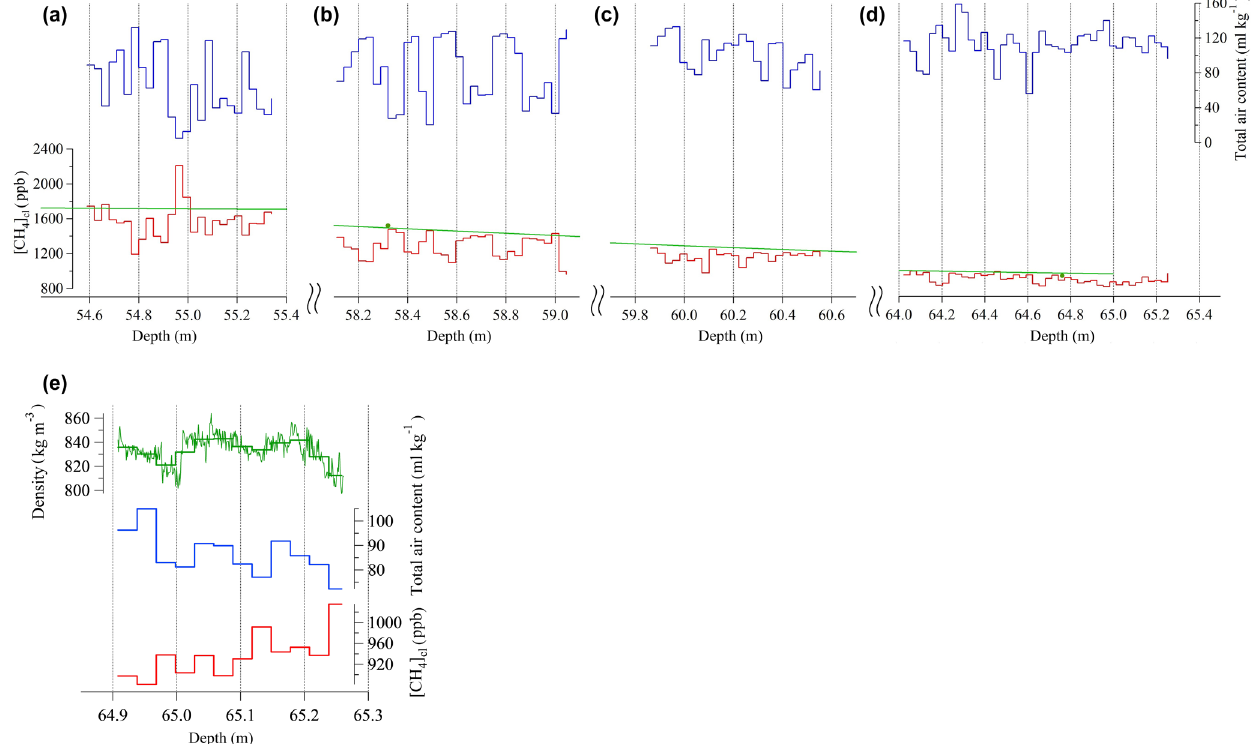
Figure 5. (a–d) CH 4 mole fraction in closed pores ([CH 4 ] cl ) (red line) and total air content (air volume per ice weight) (blue line) in the lock-in zone of Styx Glacier. (e) Comparison of density with [CH 4 ] cl and total air content near z COD . A small dashed-box in panel (d) indicates the depth interval of Fig.